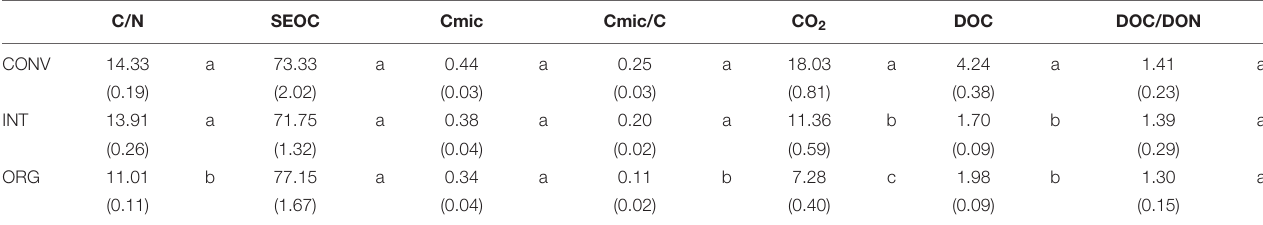
TABLE 2 | Average values ( ± standard error) of the variables investigated: C/N ratio, SEOC (mg C kg − 1 soil dw), Cmic (mg C g − 1 soil dw), Cmic/Corg ratio, CO 2 ( µ g C g − 1 soil dw d − 1 ), DOC (mg kg − 1 soil dw), and the DOC/DON ratio measured at the three kiwifruit orchards under different management practices. C/N SEOC Cmic Cmic/C CO 2 DOC DOC/DON